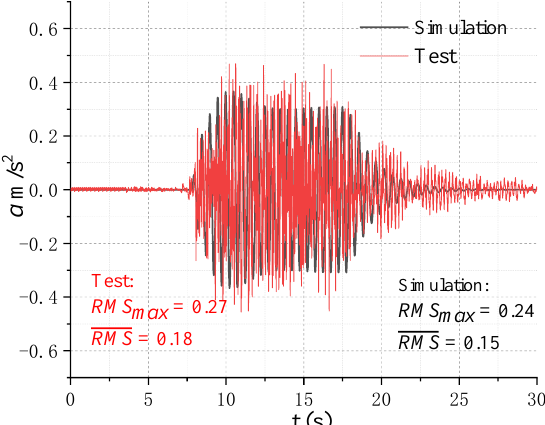
Figure 16. Comparison between simulation and measured.